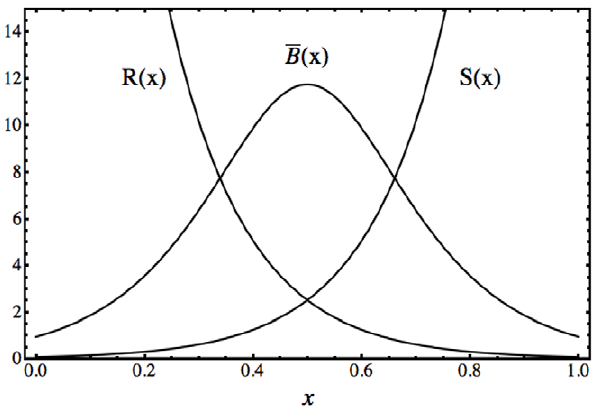
Figure 7. Steady states of proteins B , R and S for the genetic regulatory network of Figure 6. The steady state of protein B shows a spiky profile, resulting from the inhibitory action of proteins R and S . In this model, we have considered that the concentrations of R and S are constant in time and non-homogeneous in space. The activator protein A has been considered constant along the spatial region.